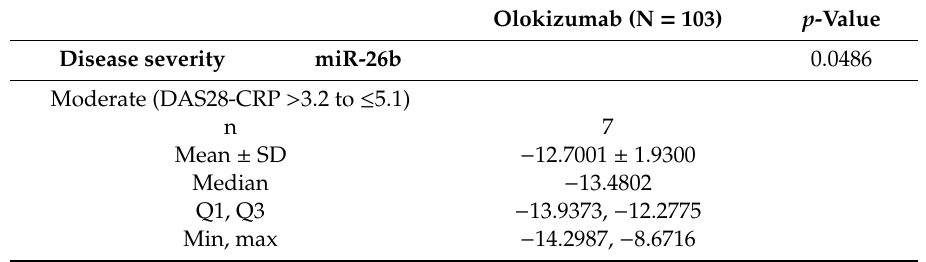
Table 5. Correlations between miR-26b, miR-29, miR-522 expression and disease severity and anti-CCP